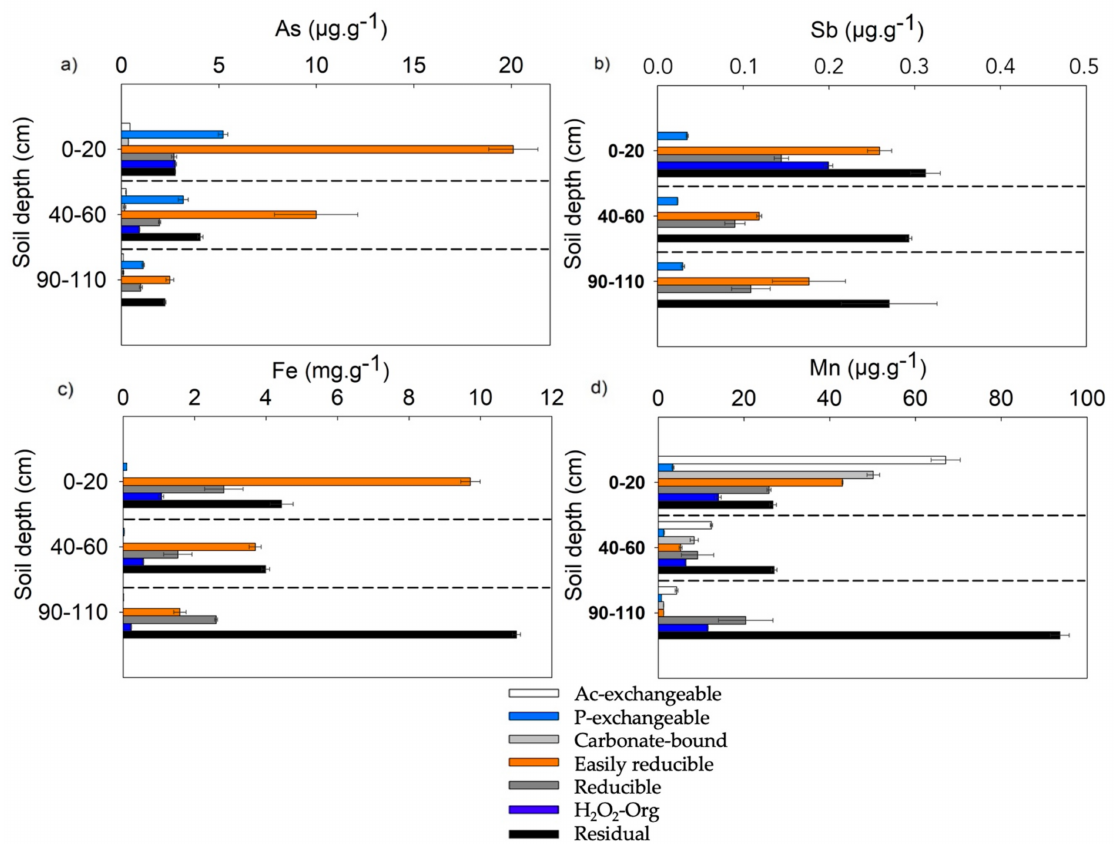
Figure 3. Solid-phase distribution of the elements ( µ g/g DW) in the three soil layers (0–20 cm, 40–60 cm and 90–110 cm): As ( a ), Sb ( b ), Fe ( c ) and Mn ( d ). Bars are represented as the mean value ± standard variation ( n =